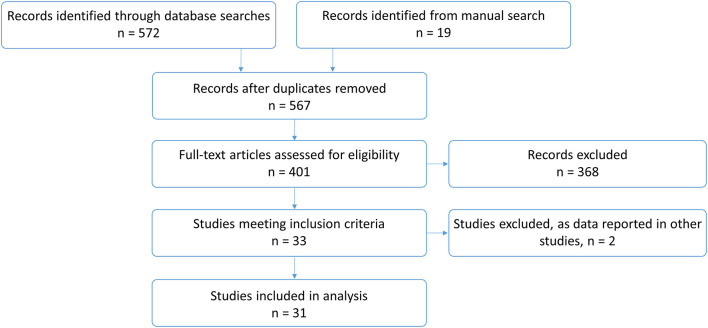
Flowchart of study selection.